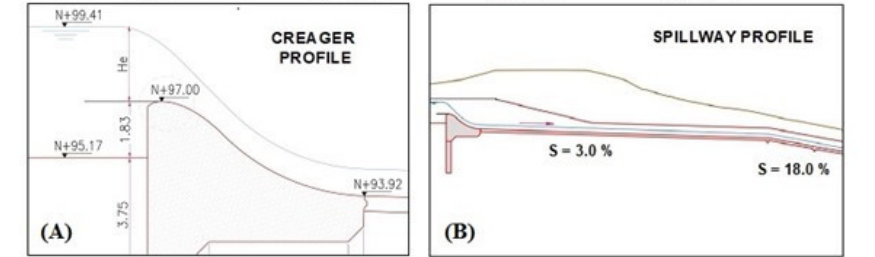
Figure 5. Spillway designed for the Sube y Baja dam. Adapted from: [61]. ( A ) Creager profile, ( B ) Spillway profile.